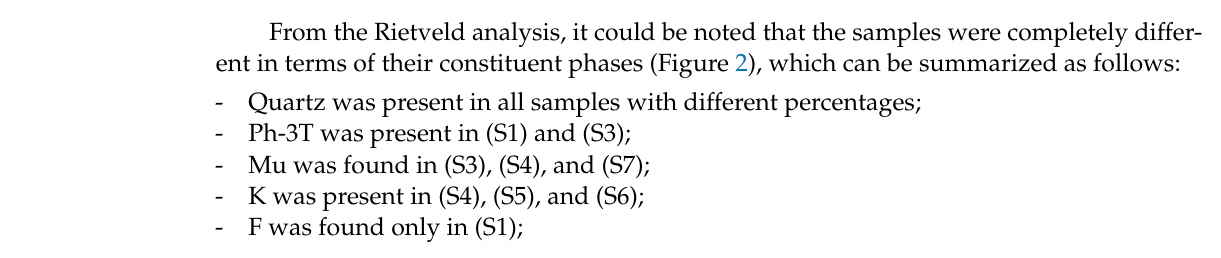
Table 2. Crystallographic parameters and properties of different phases used for the Rietveld re- finements.